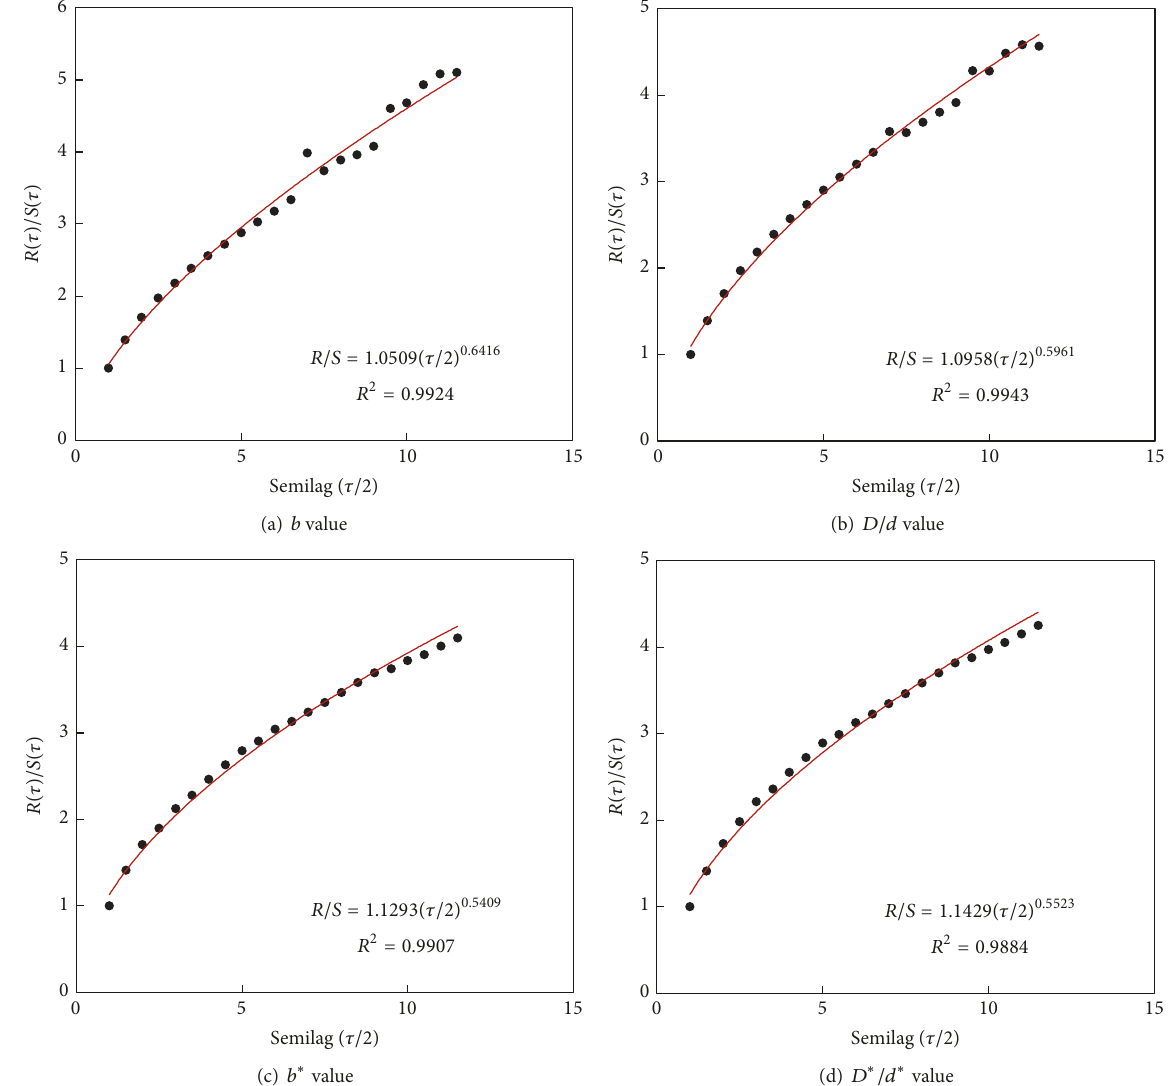
Figure 7: The plots for 𝑅/𝑆 analysis of allometric scaling exponents of Chinese cities: